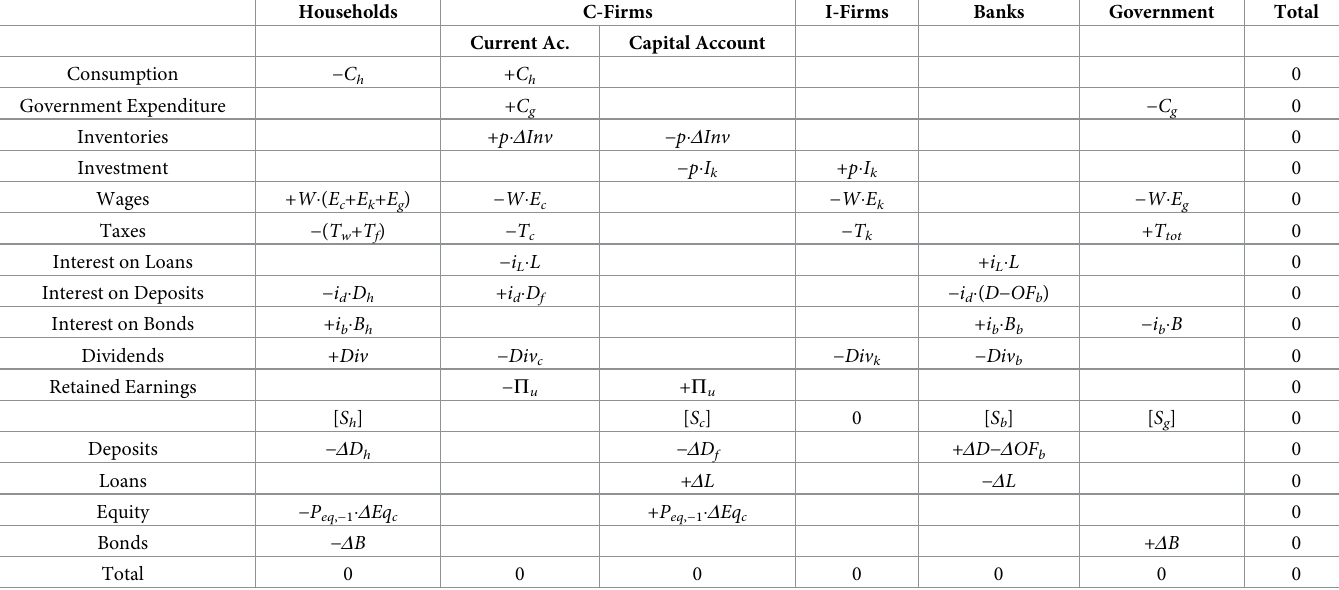
Table 2. Transaction-flow